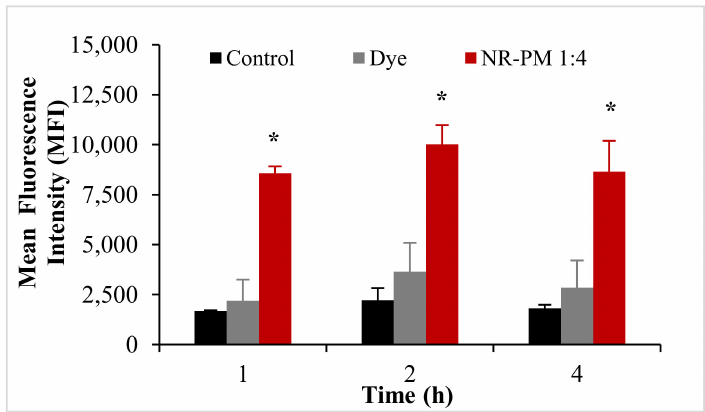
Figure 9. Mean fluorescence intensity of Nile red (NR)-PM in Caco-2 cells. Data are presented as mean ± SD, ( n = 3). * indicate statistically significant di ff erences between groups ( p <